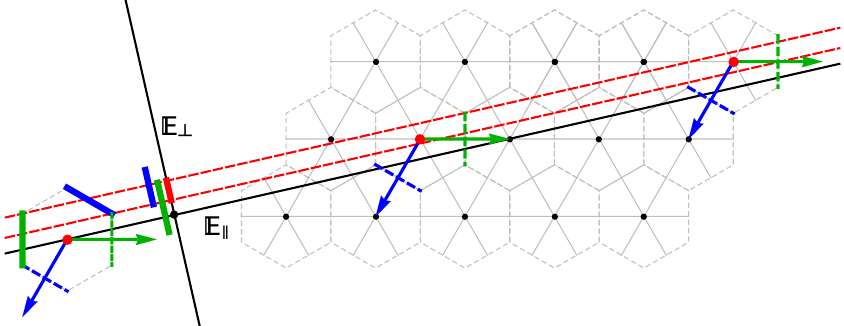
Figure 7. A vertex configuration ˜ C (the combination of blue and green tile types) and its corresponding sector s ⊂ E ⊥ (red) for the T ( A 2 ) tiling. Two tile types ˜ t (blue arrow) and ˜ t (cid:48) (green arrow) together make up the vertex configuration ˜ C = { ˜ t , ˜ t (cid:48) } . Their corresponding regions in the cut-window, r = − t ∗ ⊥ (cid:48)∗ (thick blue) and r (cid:48) = − t ⊥ (thick green) overlap in W and their intersection s = r ∩ r